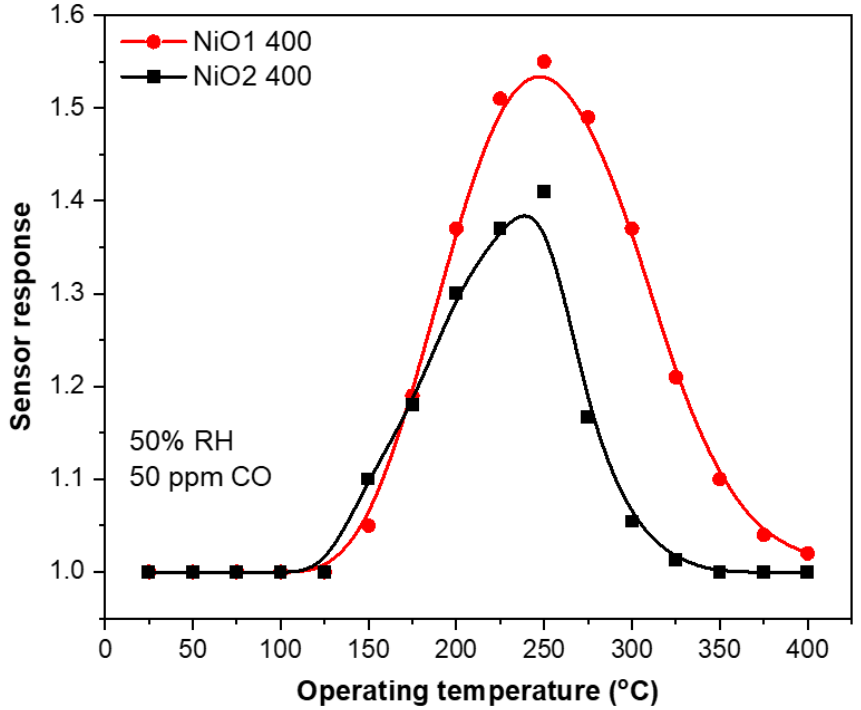
Figure 4. Sensor response of NiO1 400 and NiO2 400 to 50 ppm CO in the presence of 50% RH.